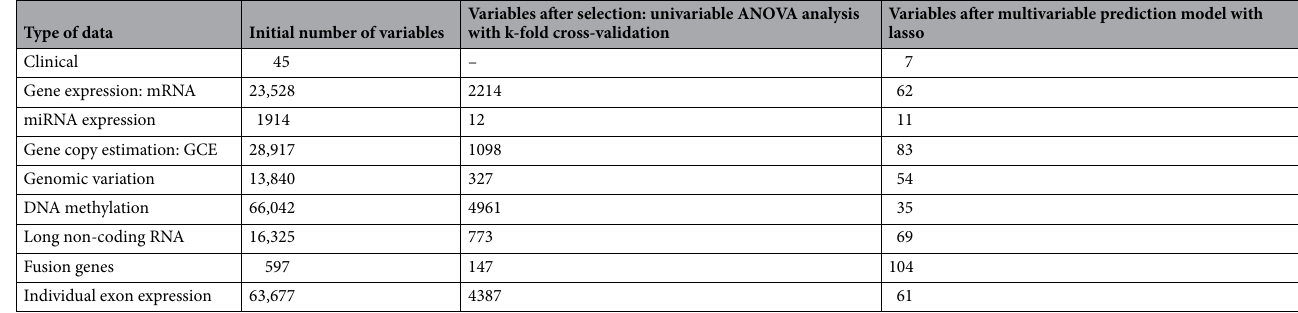
Table 2. Variable selection and variables after prediction model construction with type of data. To reduce the number of variables, we used univariate analysis of all data with ANOVA to select the variables that were more informative for prediction of response, with a p-value < 0.05 (3rd column). Features that were statistically significant in this univariate analysis were then used for multivariate lasso regression modeling. In the last column are the number of variables resulting after performing that prediction model with only one variable. Variables in this last column were used to build prediction models integrating 2 or 3 types of